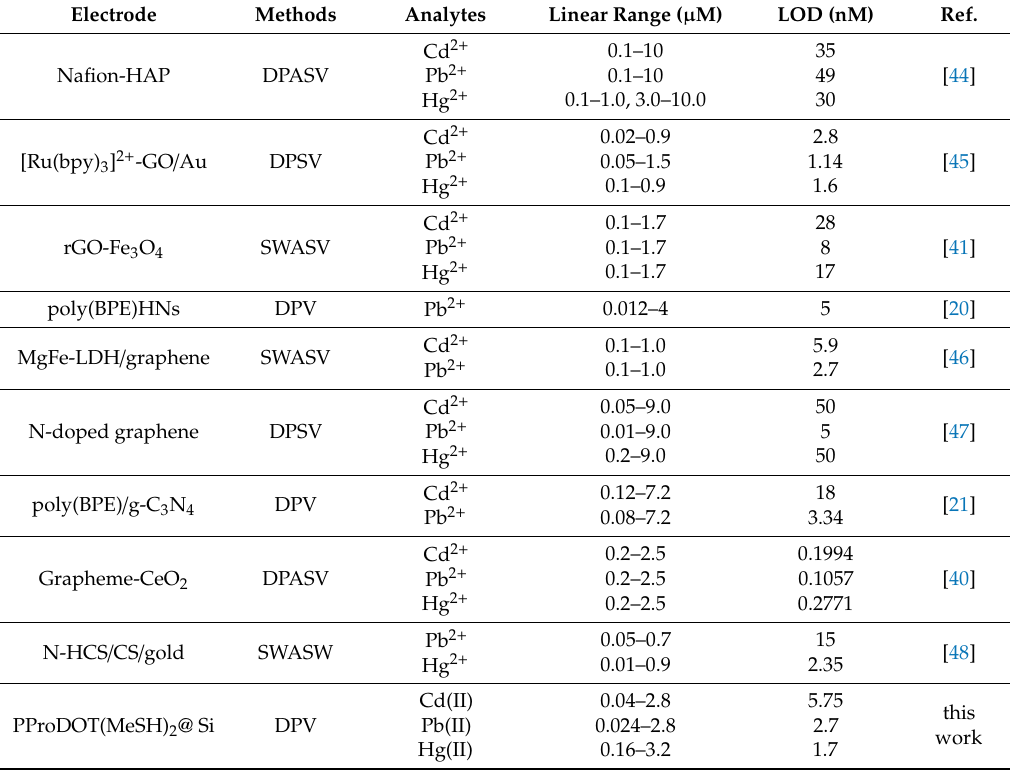
Table 2. Comparison of di ff erent sensors for the determination of heavy